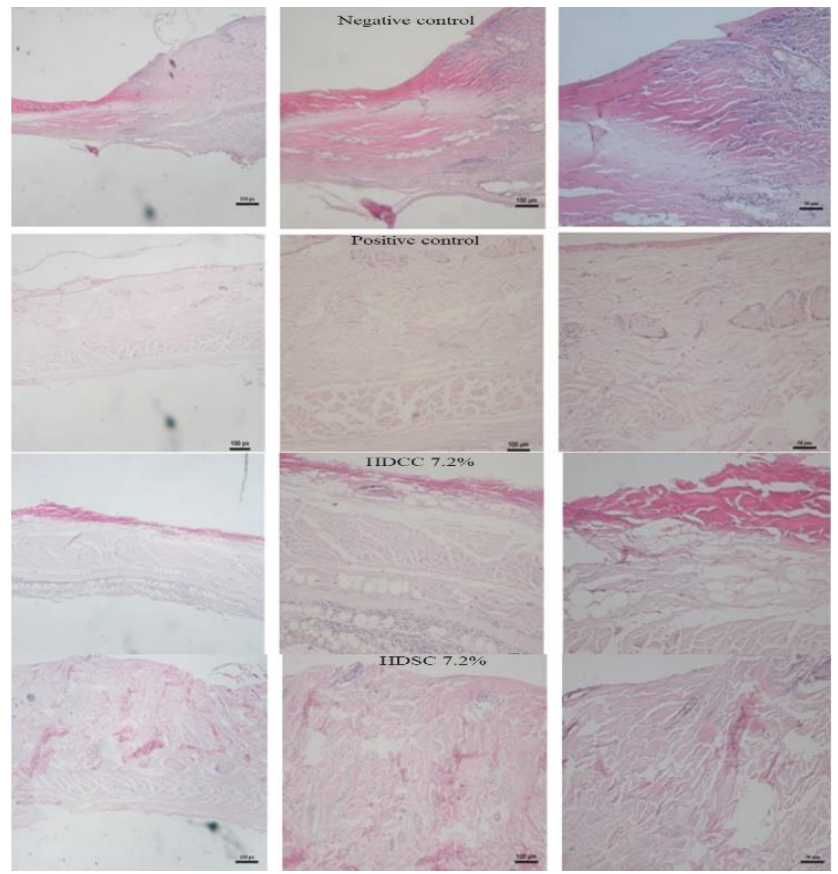
Figure 7. Histological analysis by hematoxylin and eosin presenting the characteristics tissue struc- tures and cellular infiltrates of negative control, positive control, 7.2% HDSC 7.2% and 7.2% HDCC in evaluation of wound healing.